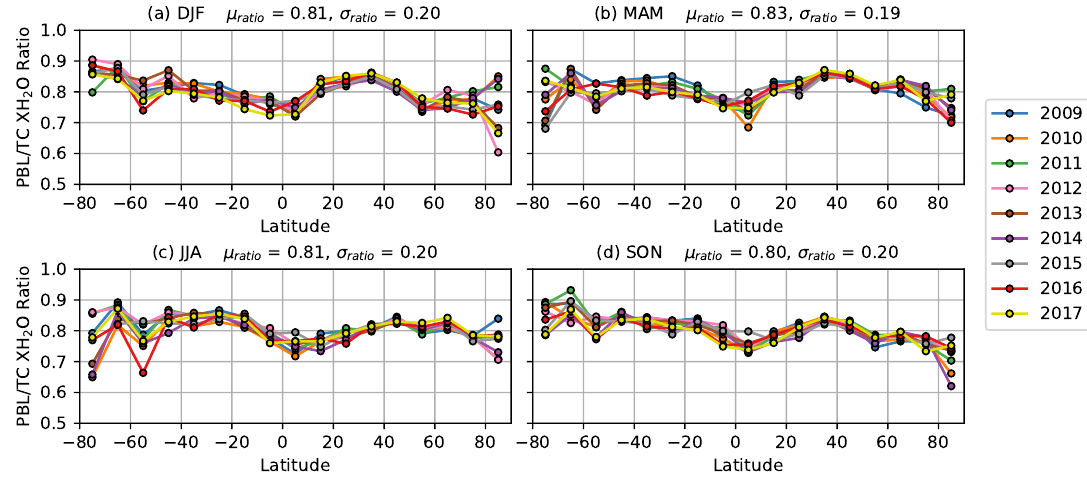
Figure 1. Ratio of PBL to total column (TC) XH 2 O concentrations calculated using profiles from the Analyzed Radio Soundings Archive (ARSA), which is described in Section 2.2.1. Ratios are shown as a function latitude, year and season, where DJF (December, January, February) is northern hemisphere (NH) winter, MAM (March, April, May) is NH spring, JJA (June, July, August) is NH summer, and SON (September, October, November) is NH autumn. Latitudinal cross sections are shown for each year of the study with the overall ratio mean ( µ ratio ) and standard deviation ( σ ratio ) for all years shown in the